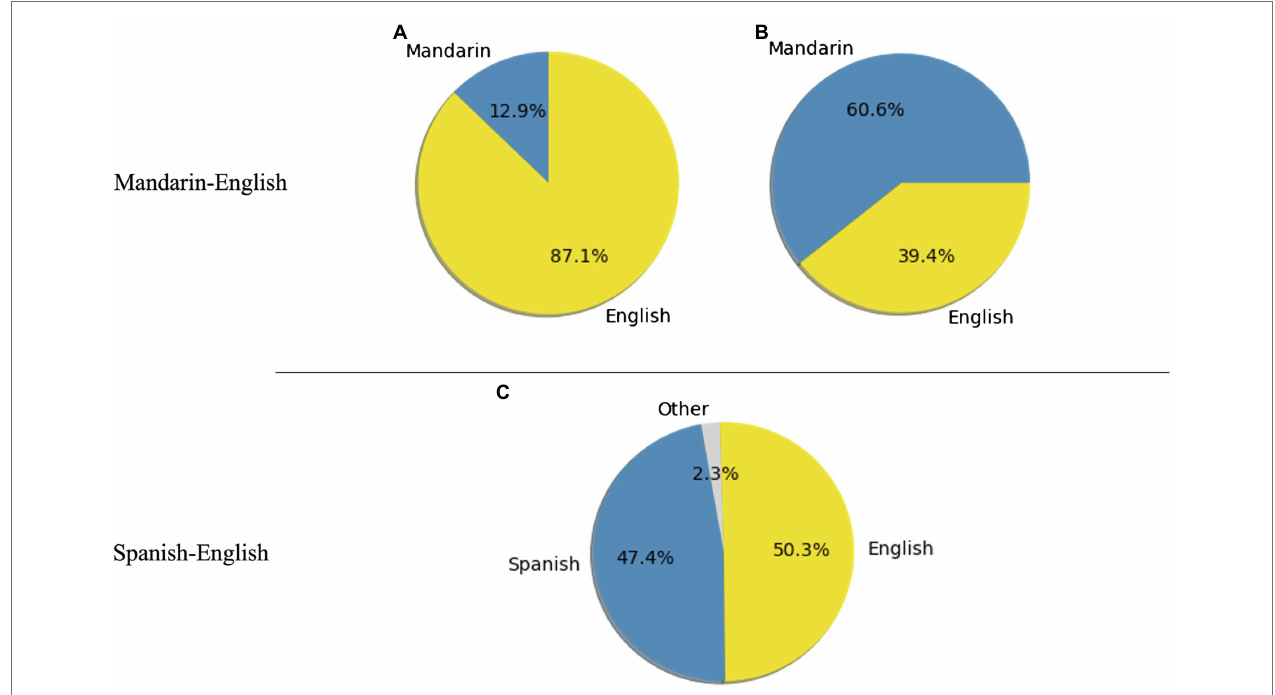
FIGURE 4 | Proportions of words within each community in Mandarin-English, (A) and (B) , and Spanish-English, (C) . Networks are based on intra-sentential sentences and word2vec embeddings. For the Spanish-English plots, “Other” represents words with ambiguous language